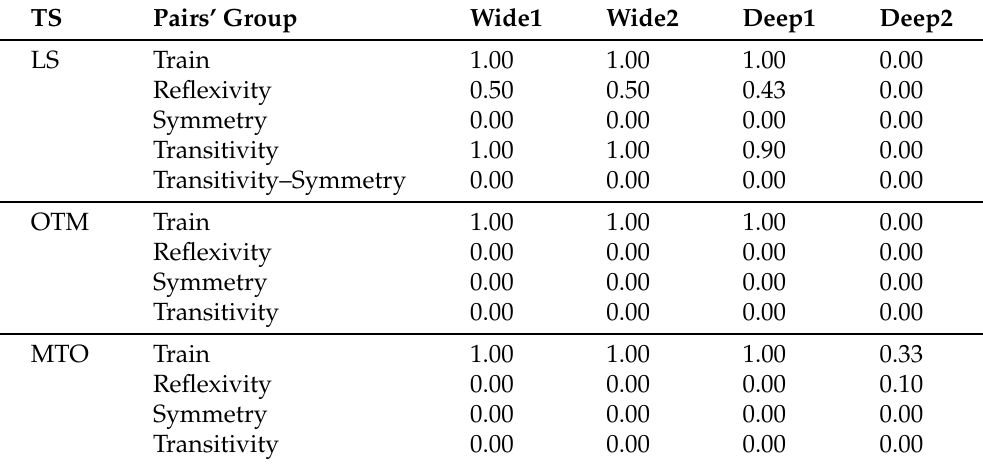
Table 3. Agents’ F1-score by the TS and pairs’ group.